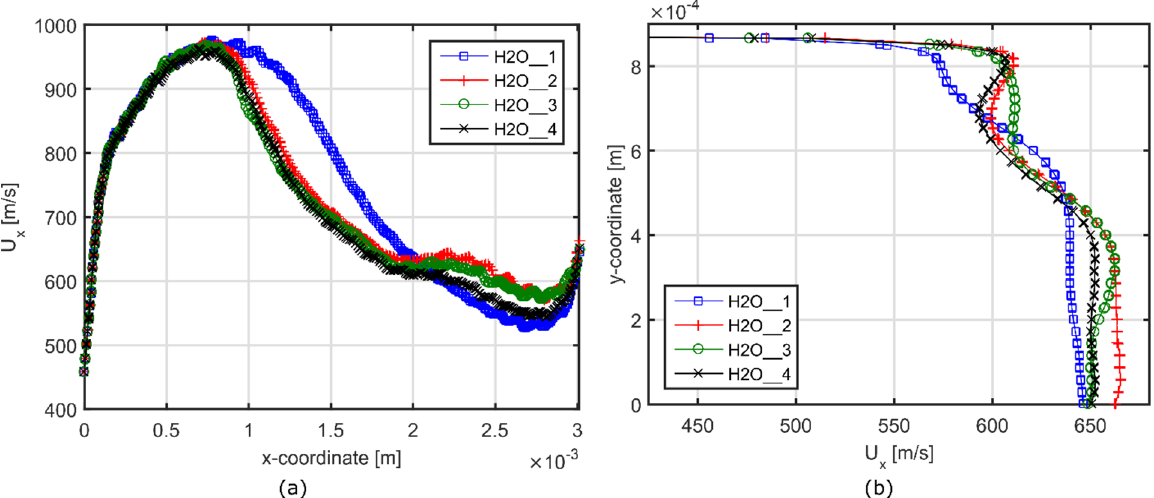
Figure 8. Profiles of the axial velocity U x for the water vapor flow in the symmetry plane (0, x,y ): ( a ) at y = 0 m (along the symmetry axis); ( b ) at x = 0.00301 m (along the width-wise direction). Test cases: H2O_1 (baseline); H2O_2 (additional mass flow rate with jet 1 = ON, jet 2 = OFF); H2O_3 (additional mass flow rate with jet 1 = ON, jet 2 = ON); H2O_4 (bypassed mass flow rate with jet 1 = ON, jet 2 = OFF).